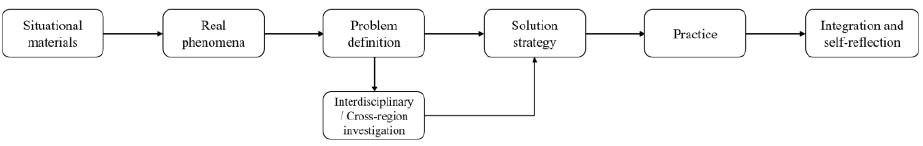
Figure 6. Process flow of competence-oriented instruction.